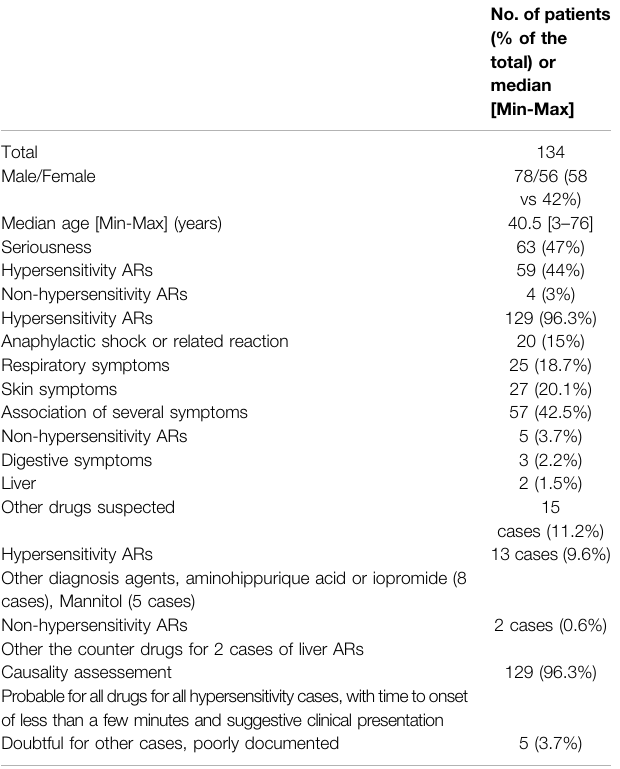
TABLE 1 | Characteristics of 134 ARs to inulin and sinistrin registered in the FPVD and in the VigiBase from 1991 to 2018.